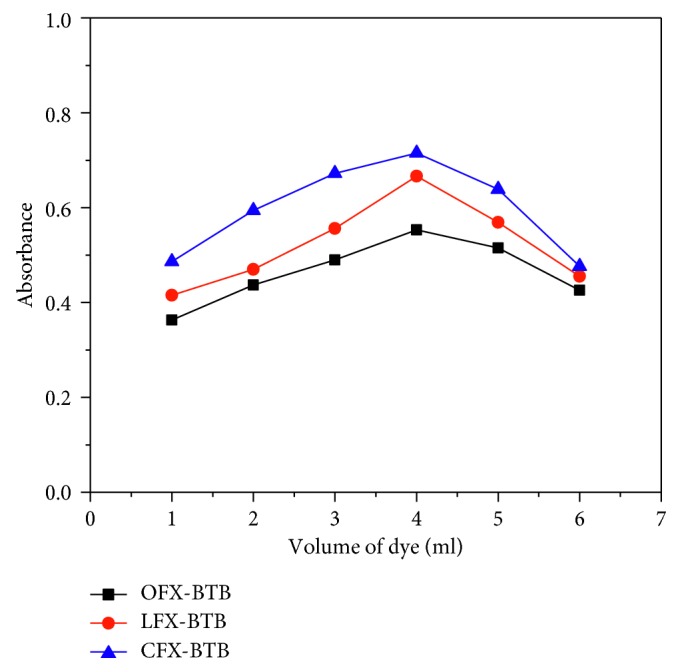
Effect of the volume of 0.025% BTB on the absorbance of 10 μg/mL of OFX, LFX, and CFX.